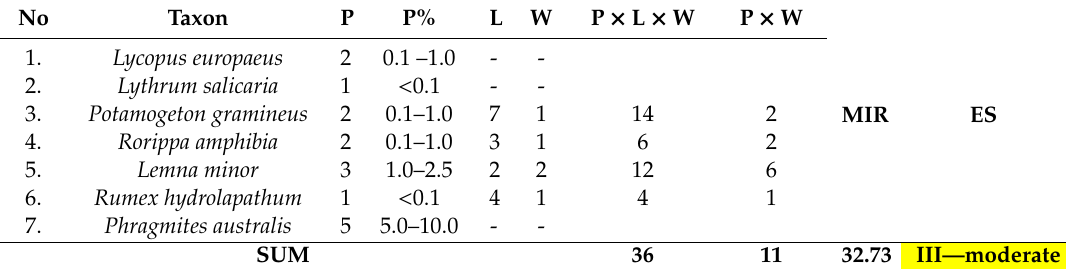
Table 8. Summary of MMOR results, May 2017, section below the barrage on the